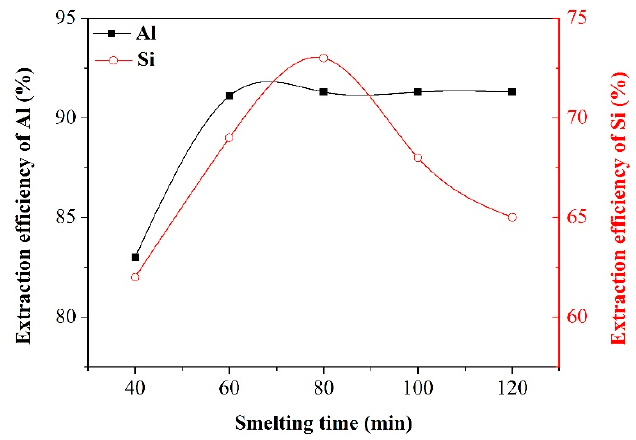
Figure 7. Effect of smelting time on the extraction efficiency of Al and Si. Figure 7. E ff ect of smelting time on the extraction e ffi ciency of Al and